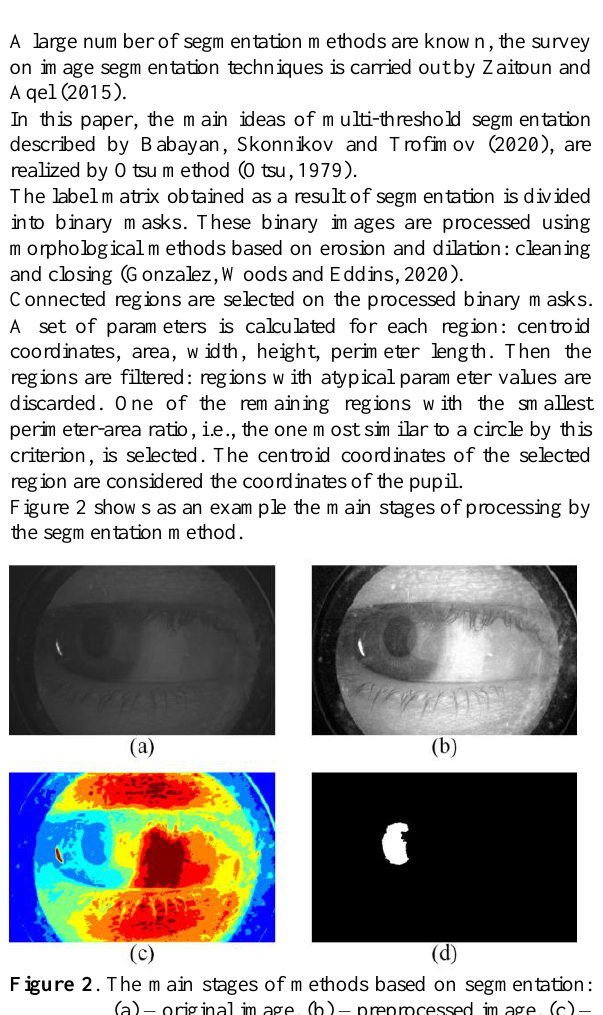
Figure 2 . The main stages of methods based on segmentation: (a) – original image, (b) – preprocessed image, (c) – label matrix, (d) – binary mask after morphological processing. Figure 3 . Example of the criterion function typical for